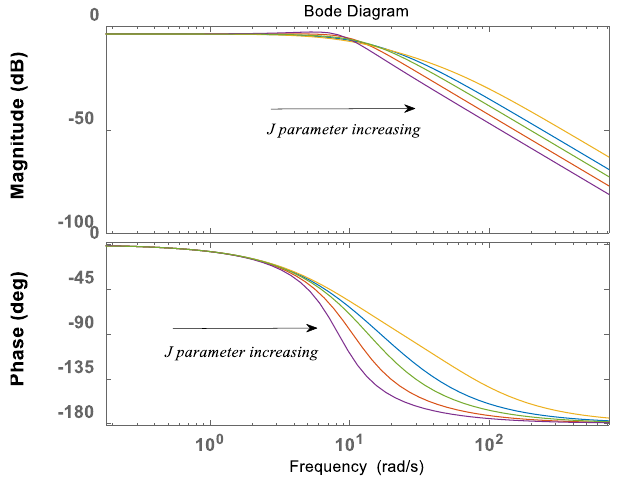
Figure 11. Bode diagram of the active power transfer function.